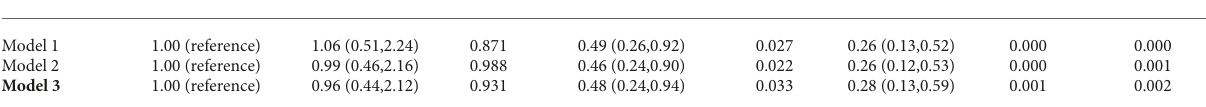
TABLE8 Oddsratiosand95%CIsfromlogisticregressionmodelsfortheassociationbetweengreenteaconsumptionandmildcognitiveimpairment. Logistic regression